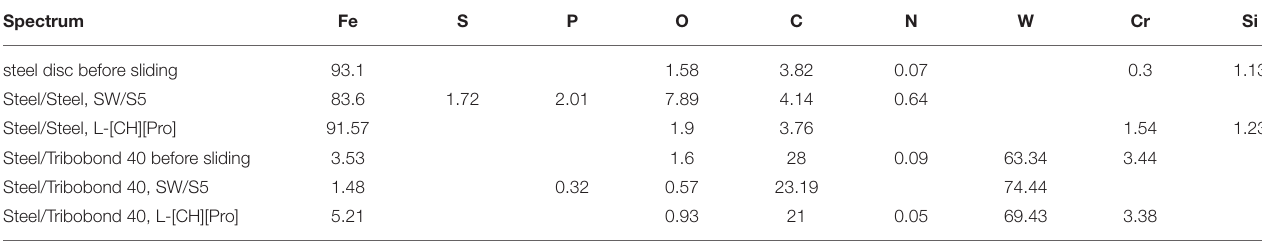
TABLE 2 | Elemental wt% of EDS study on the worn surface of disks. Spectrum Fe S P O C N W Cr Si